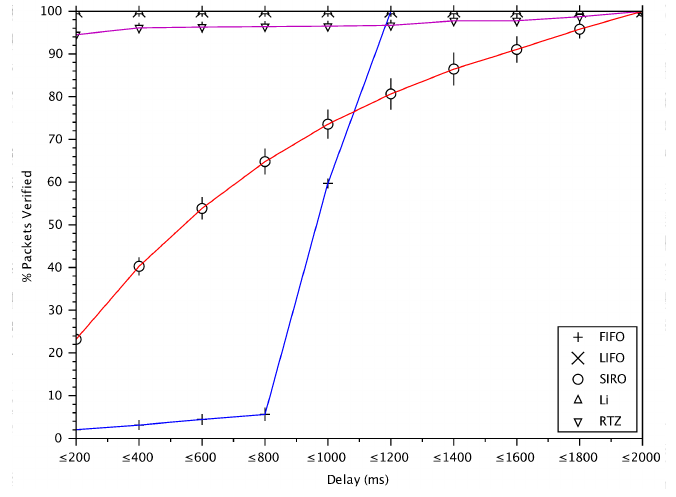
Figure 10. The cumulative percentage of verified messages versus delay of verified messages.